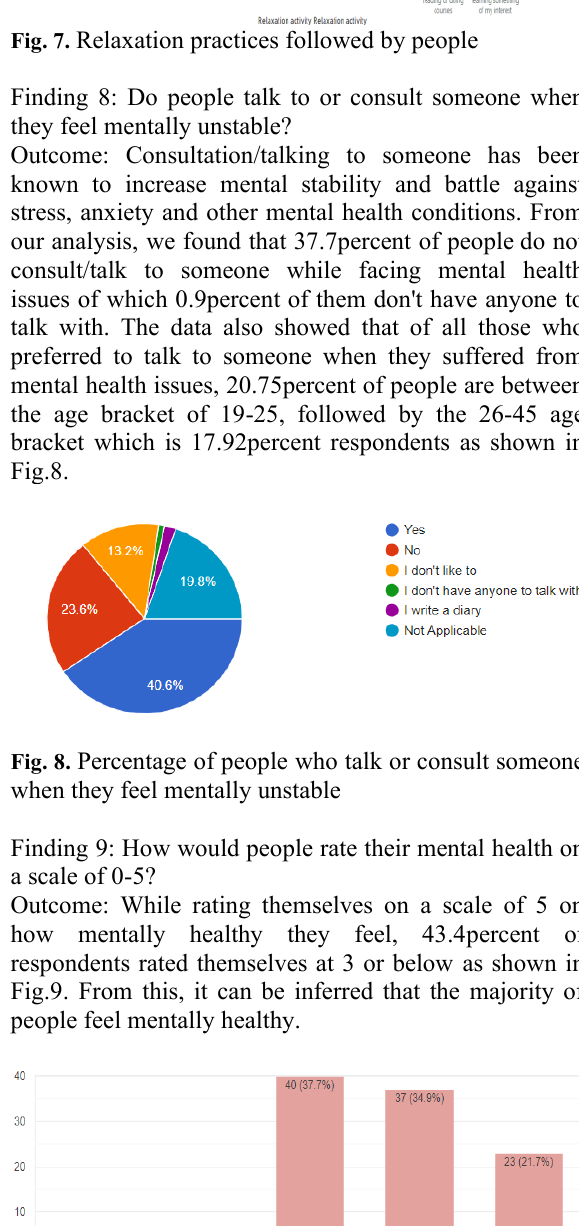
Fig. 9. People rating their mental